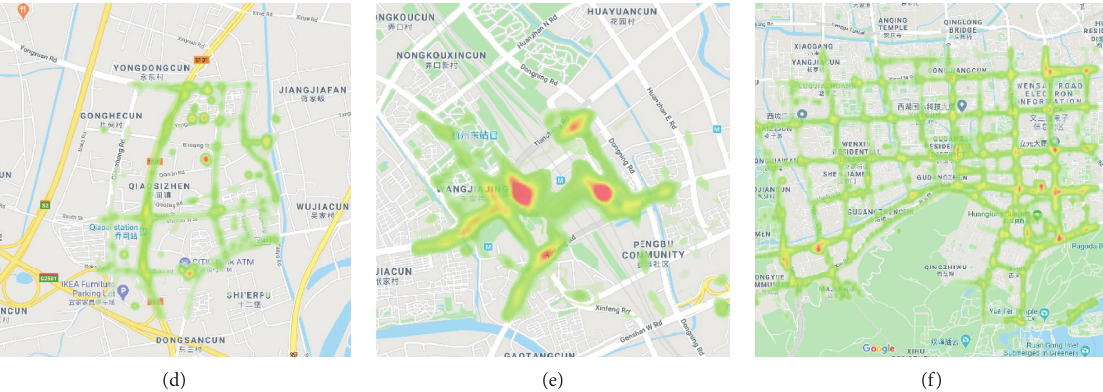
Figure 3: The heat map of the taxi flow. (a), (e) Hangzhou’s transportation hub. (c), (f) Hangzhou’s urban core area. (b) Education area. (d) Residents’ living